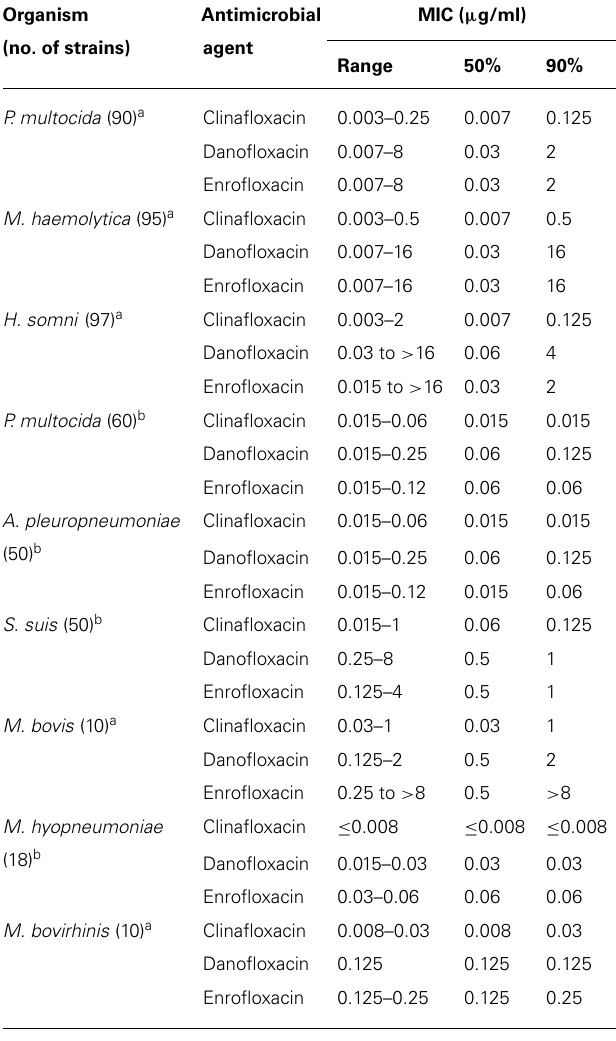
Table 1 | In vitro MIC determinations of clinafloxacin and comparator